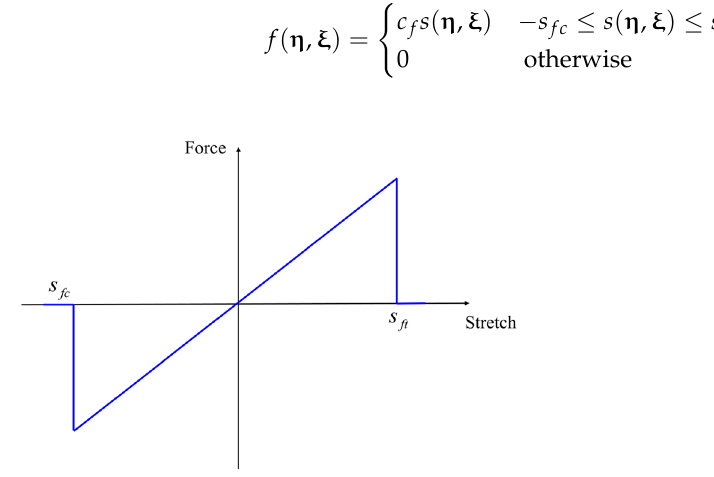
Figure 4. PD constitutive relation of the fiber bond.